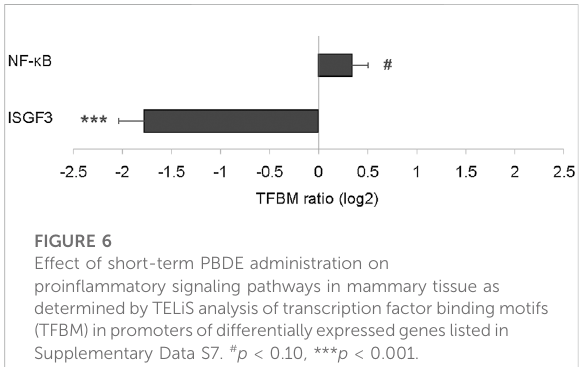
FIGURE 6 Effect of short-term PBDE administration